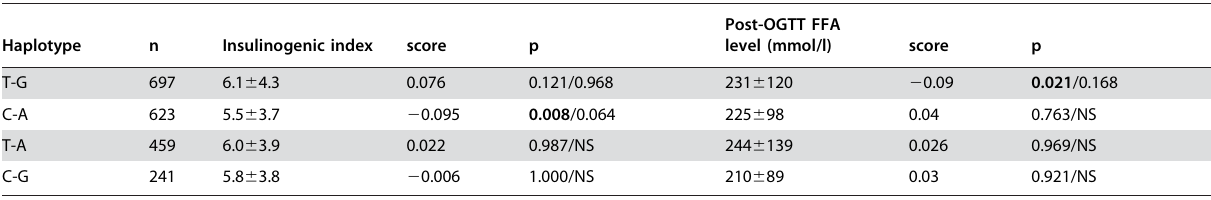
Legend to Table 5. n=1011. Data are mean 6 SD. Scores of the linear regression analysis are reported. Both nominal and the Bonferroni-corrected p-values are shown. NS: not significant.